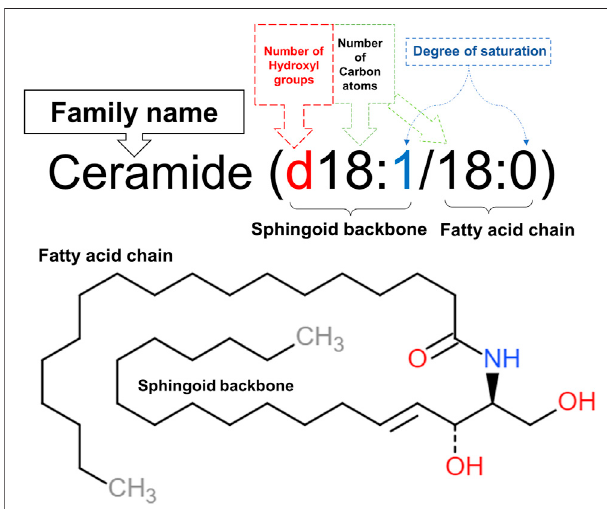
FIGURE1| NomenclatureofC18:0ceramide(d18:1/18:0).The fi rstpart of the name (d18:1) denotes the 18 carbon atoms, having one doublebond in its sphingoid backbone along with two hydroxyl groups. This sphingosine chain is attached to a saturated fatty acid chain, represented by the second part of the name (18:0), through an amide bond. This illustration was adapted from caymanchem.com.